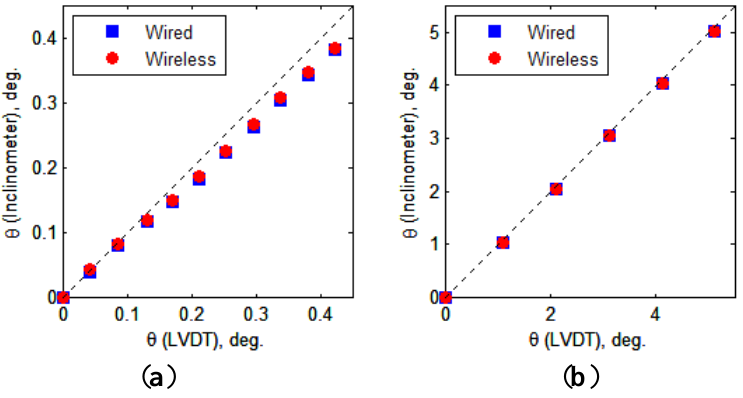
Figure 13. Relationship between inclinations calculated from LVDTs measurements and measured by inclinometers. ( a ) Case 1 (0–0.38°); ( b ) Case 2 (0–5°).